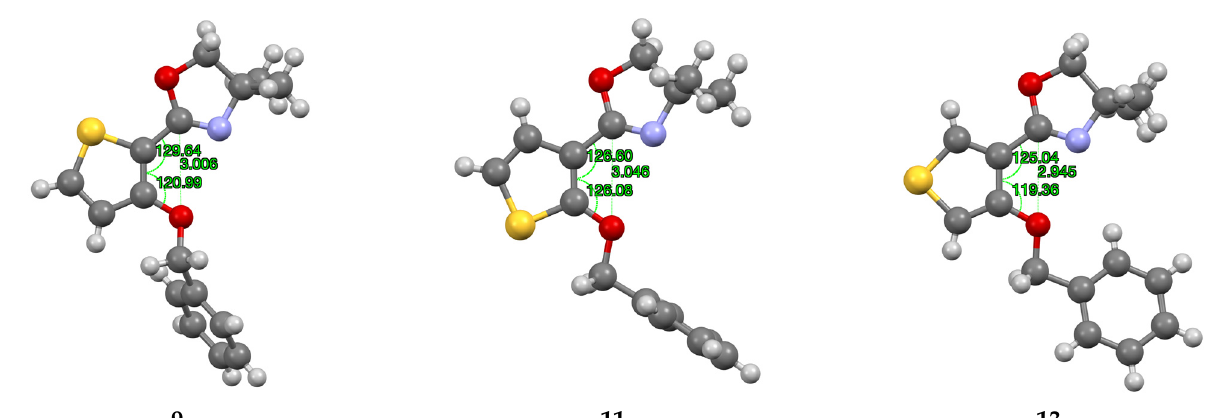
Figure 3. Molecular structures of 9 , 11 and 13 showing angles (°) and benzyloxy O to oxazoline C(2) distance (Å).